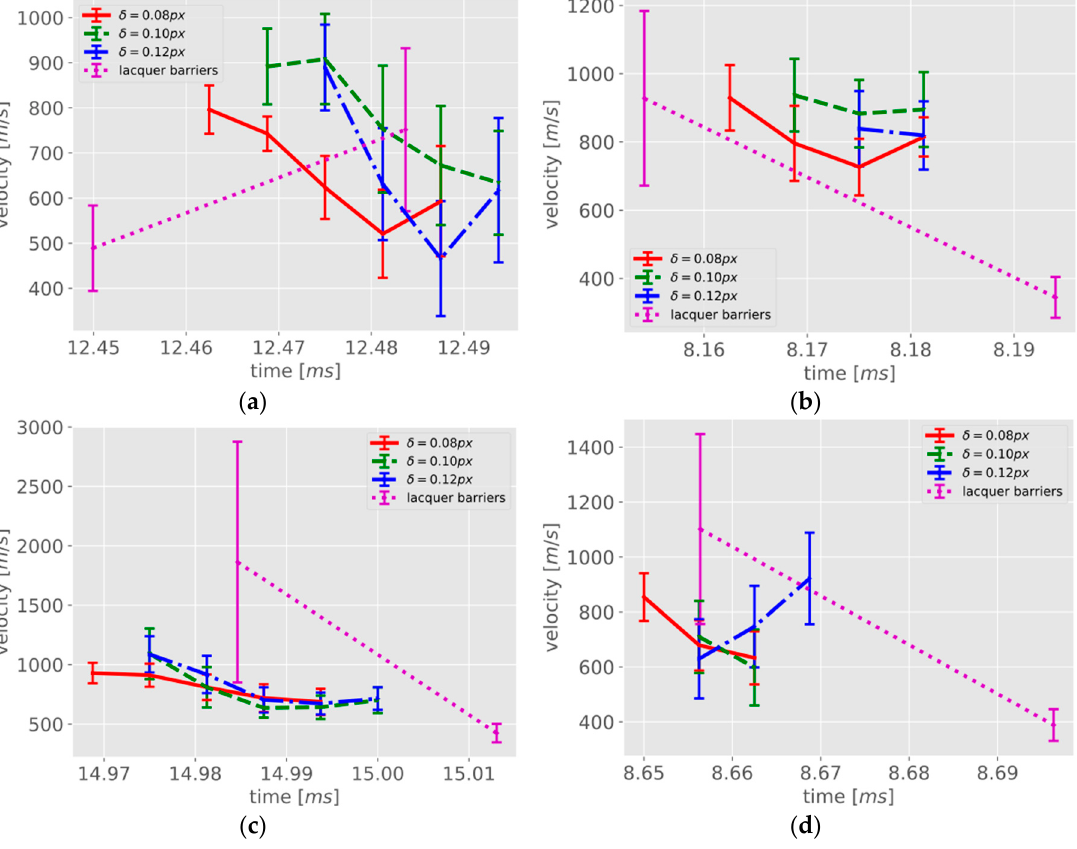
Figure 14. Crack propagation velocities and the corresponding error bars (±one standard deviation) obtained using the photogrammetric technique with different thresholds for deformed triangles (red, green, blue) and using the conductive lacquer barriers (magenta): ( a ) 1st sample; ( b ) 2nd sample; ( c ) 3rd sample; ( d ) 4th sample.